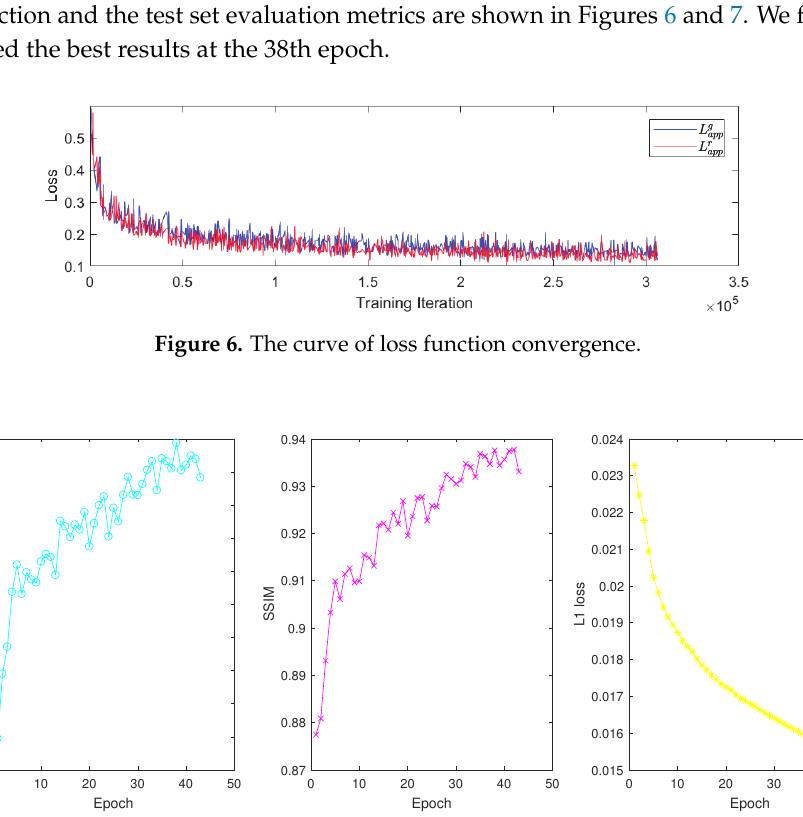
Figure 7. The curve of evaluation metrics